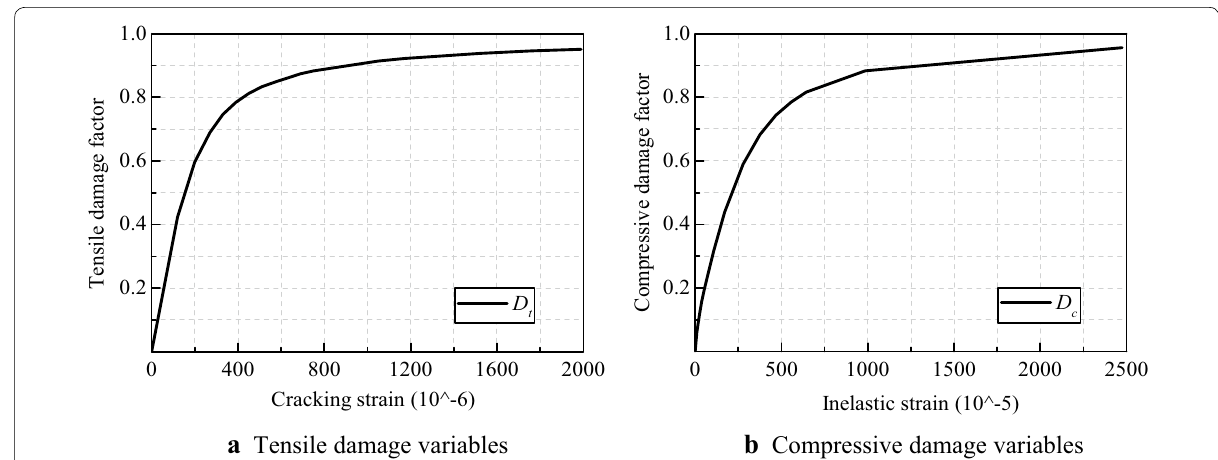
Fig. 16 Damage variables.